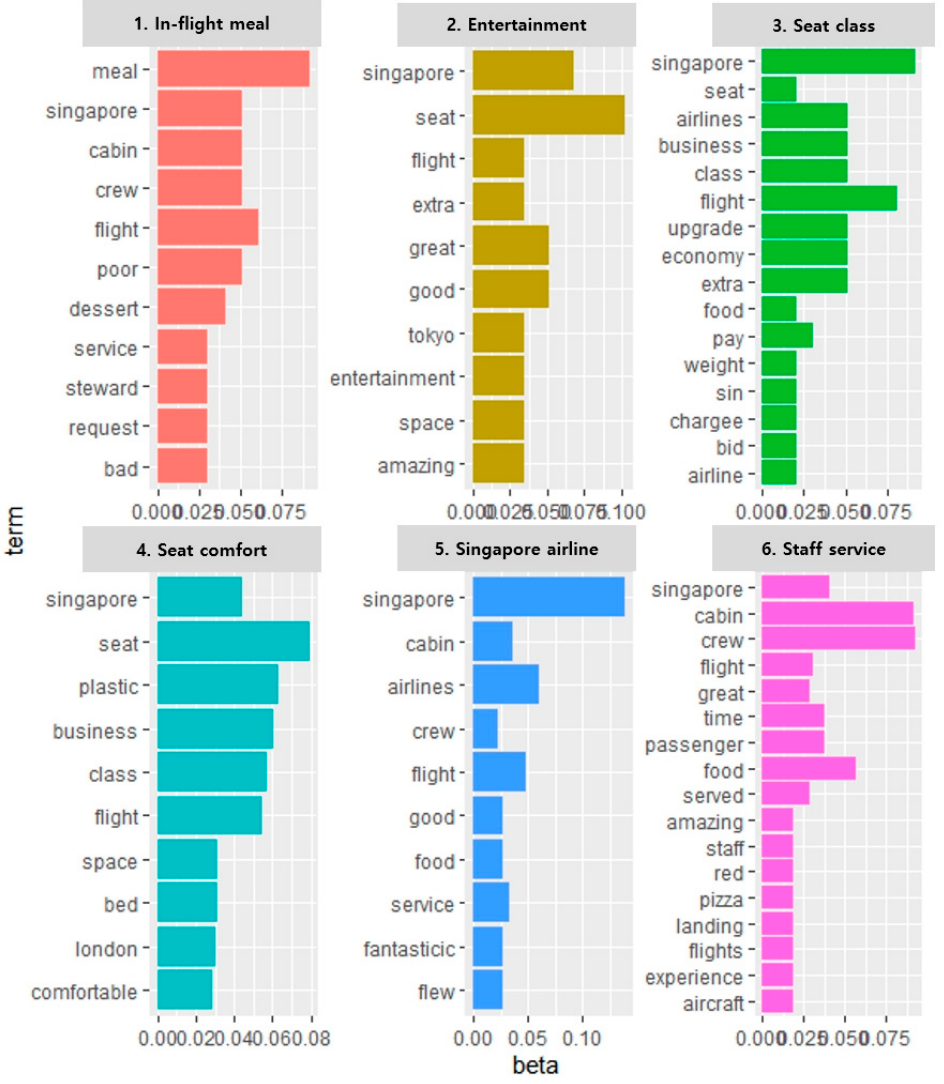
Figure 4. The result of topic modeling.